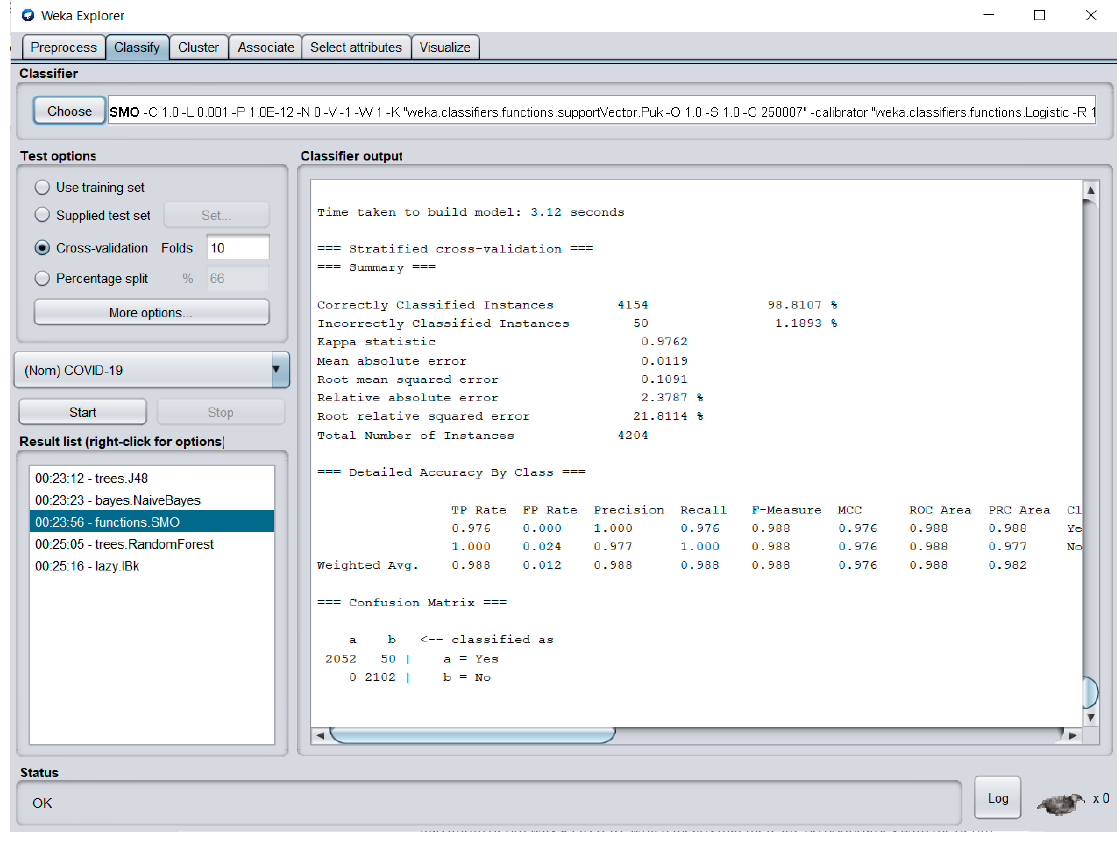
Figure 6. The Classify tab of WEKA Explorer wherein the user can choose different algorithms to be applied to the dataset. The details concerning the developed model’s performance were displayed in the classifier output section.